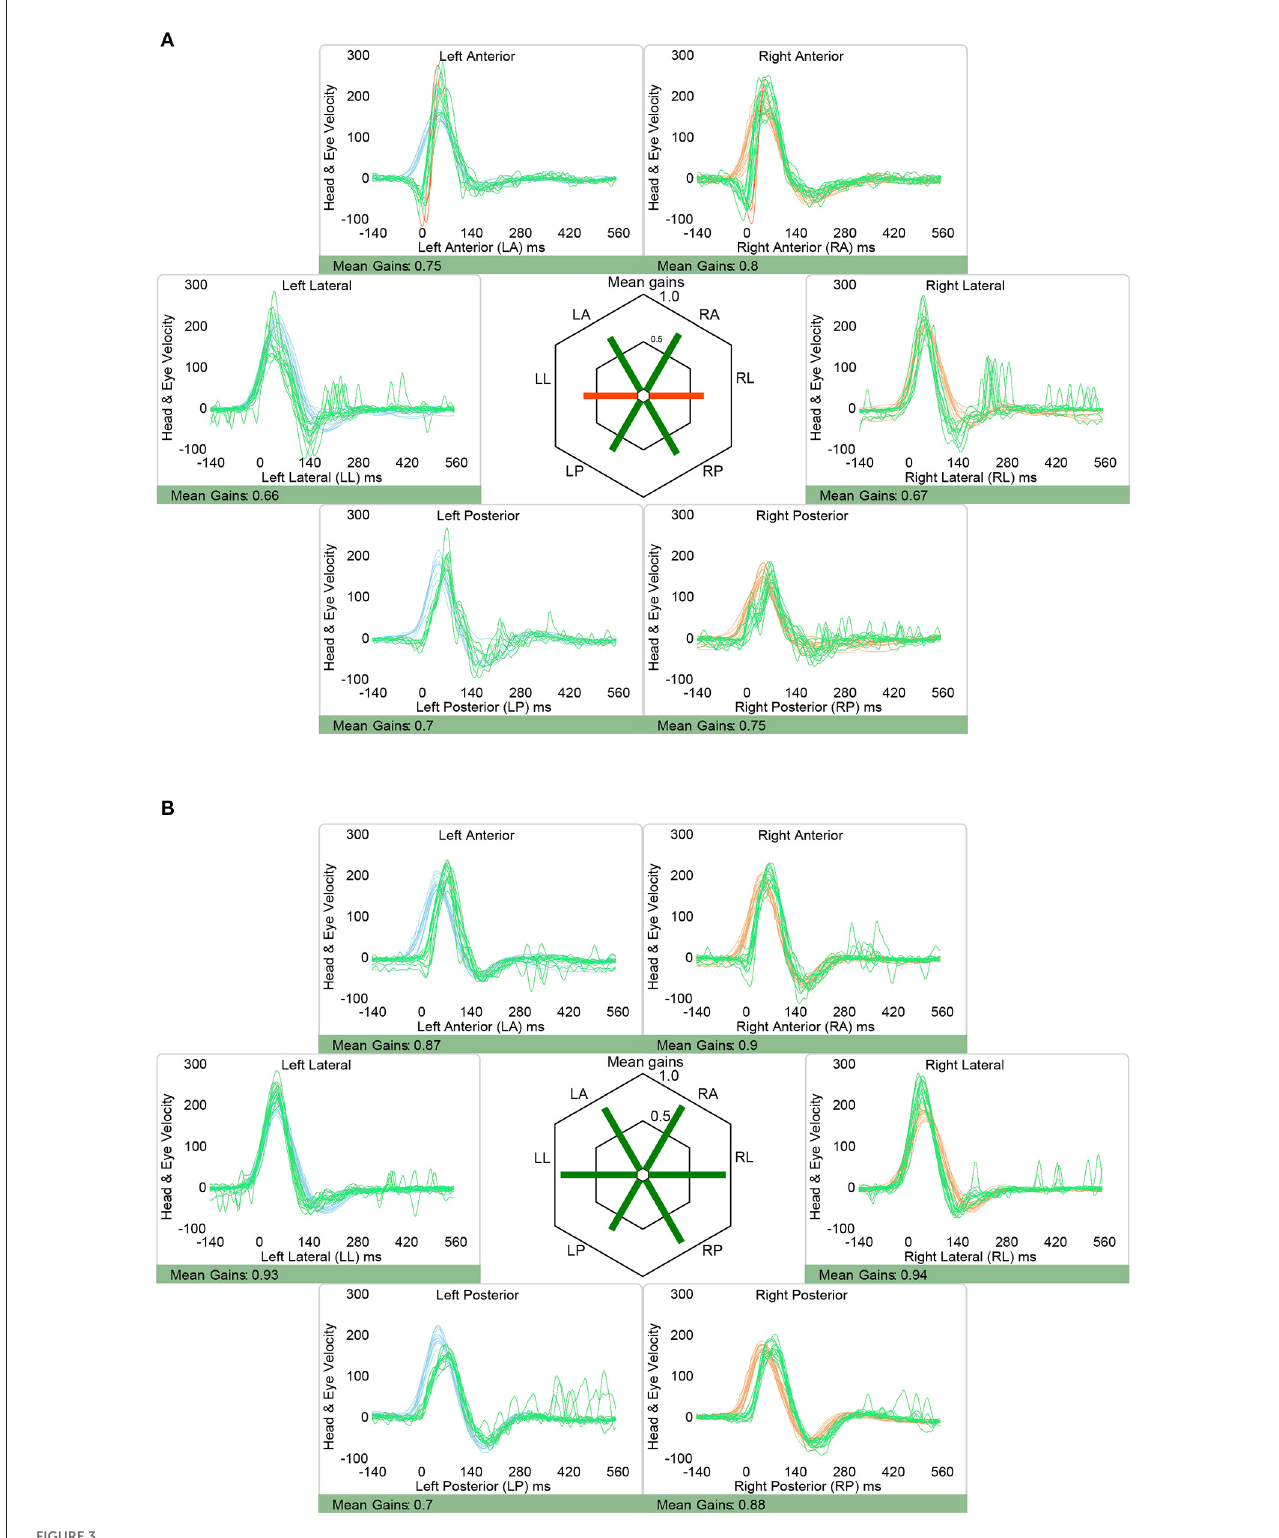
FIGURE3 Representative video head impulse testing from two patients with isolated nodular infarction, demonstrating slightly reduced aVOR-response in the horizontal canals in one patient [ (A) , case 2] and preserved aVOR-response in all six semicircular canals in the other illustrative patient [ (B) , case 6]. Note that in both patients vHIT responses were judged as overall normal, however, it is acknowledged that the saccades observed when testing the right horizontal canal in case 2 may be considered clinically relevant also, reflecting minor aVOR impairment for this canal. Eye velocity traces (in green) and head velocity traces (in red for testing the right vestibular organ and in blue for assessing the left vestibular organ) are plotted against time. Note that eye velocity traces were inverted for better visualization and comparison with the head velocity traces and that gain was calculated as the ratio of the area under the desaccaded eye-velocity curve to the area under the head-velocity curve, corresponding to a desaccaded position gain. Summary plots in the center illustrate average individual vestibulo-ocular reflex (VOR)-gains ± 1SD for all six